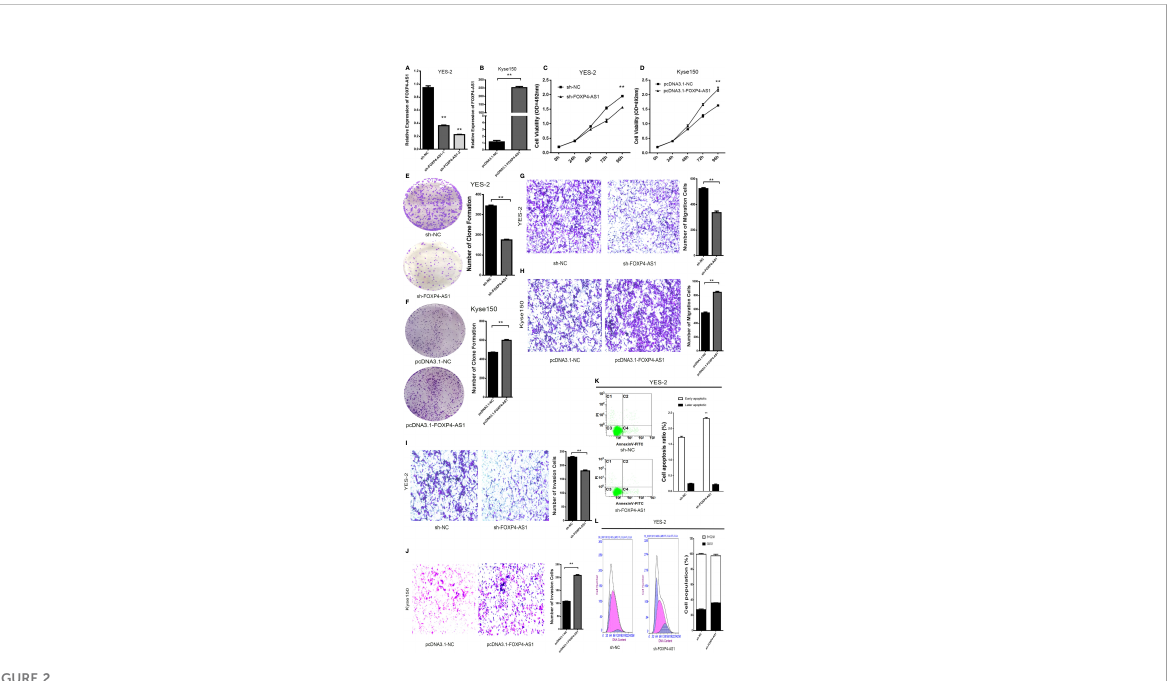
FIGURE 2 FOXP4-AS1 promotes the malignant progression of ESCC. Expression of FOXP4-AS1 in transfected sh-FOXP4-AS1 (A) or pcDNA3.1-FOXP4-AS1 (B) by qRT – PCR. (C) MTS assay showing the inhibition of YES-2 proliferation ability with sh-FOXP4-AS1. (D) Increased proliferative capacity of Kyse150 with pcDNA3.1-FOXP4-AS1 by MTS assay. (E) Colony formation assay indicates that the number of colony formation in YES-2 cells was reduced after FOXP4-AS1 deregulation. (F) Improved colony formation in Kyse150 cells transfected with pcDNA3.1-FOXP4-AS1. Transwell migration (G) and invasion assays (I) showing the decreased trans-cells of YES-2 with sh-FOXP4-AS1. Transwell migration (H) and invasion assays (J) demonstrated more Kyse150 trans-cells with pcDNA3.1-FOXP4-AS1. Apoptosis (K) and cycle (L) pro fi les of YES-2 cells transfected with sh-FOXP4-AS1 by FCM. ** p <